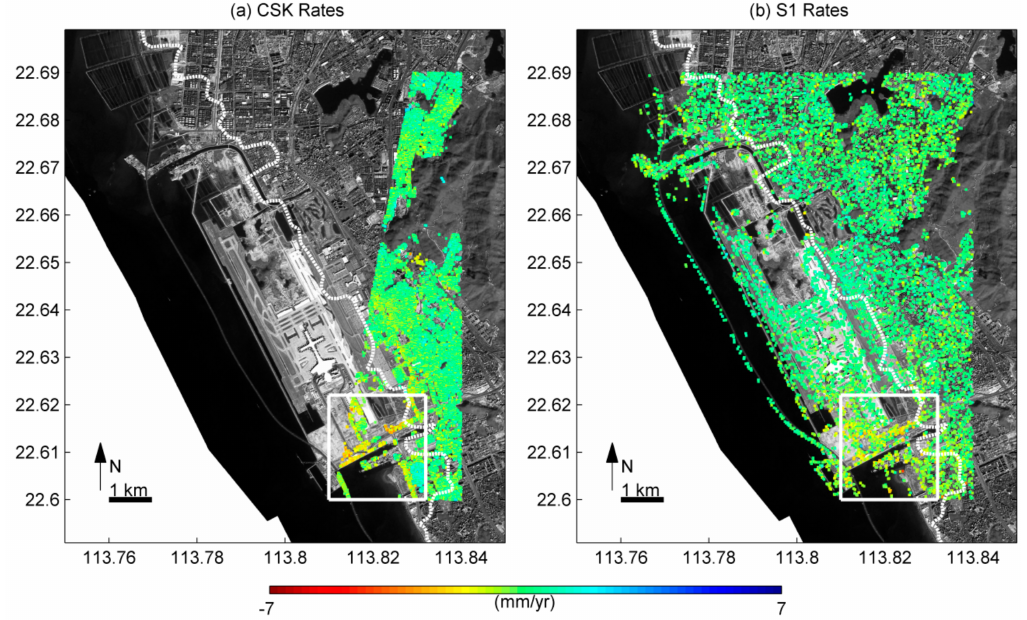
Figure 9. ( a ) CSK and ( b ) S1 mean rates to the south of Shenzhen Bao’an International Airport. The white dashed line is the coastline in 1979. Subsidence is outlined by white